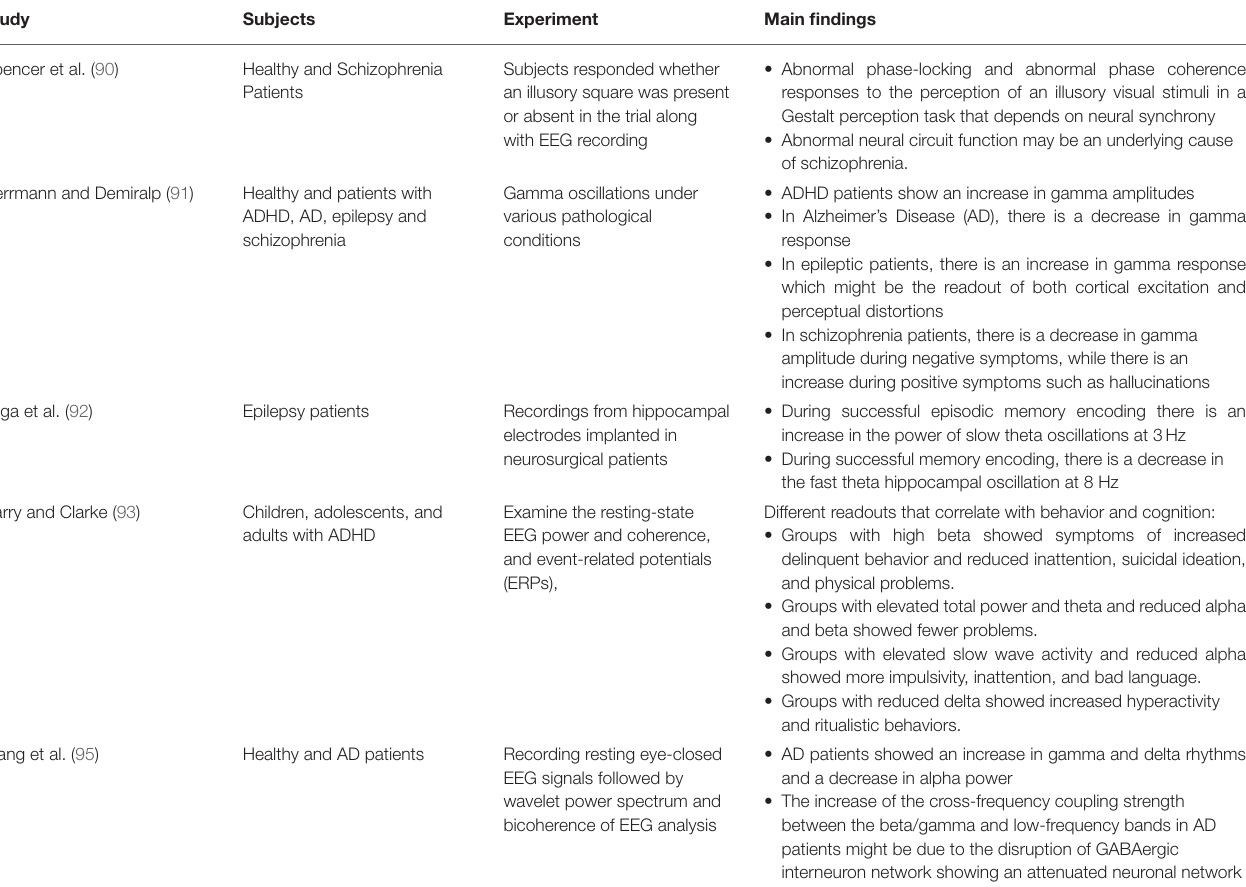
TABLE 2 | Summary of cited clinical